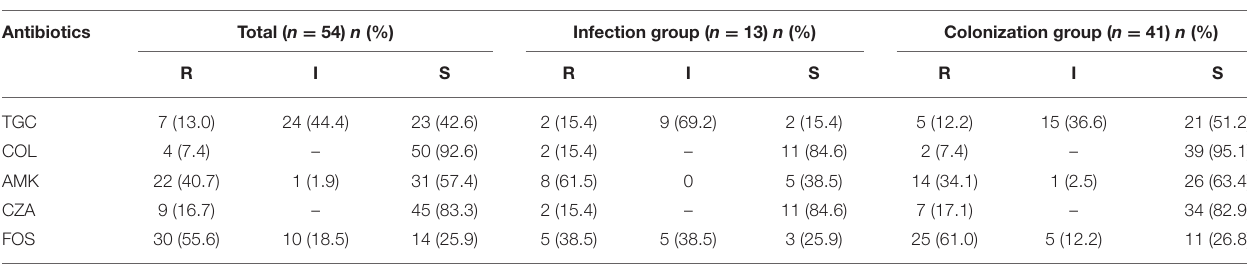
TABLE 3 | Resistance profile of CRKP strains colonized in the